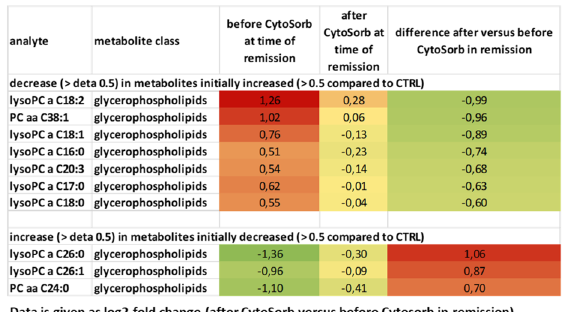
Table 5. Difference in metabolites after versus before CytoSorb in remission measured by mass spectrometry. Table shows metabolites that were initially increased > 0.5 and decreased more than > 0.5 as well as metabolites that were initially decreased and increased more than > 0.5. All values are given as Log2 (FSGS patient/stable transplanted control). Color shades represent values as heat